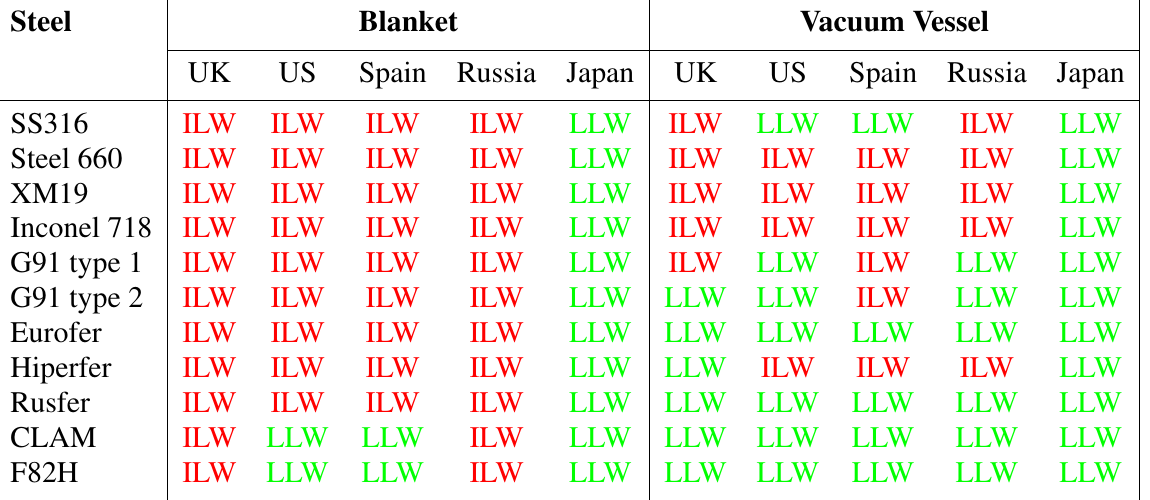
Table 3: Waste classifications for the steels studied for each set of waste disposal criteria.